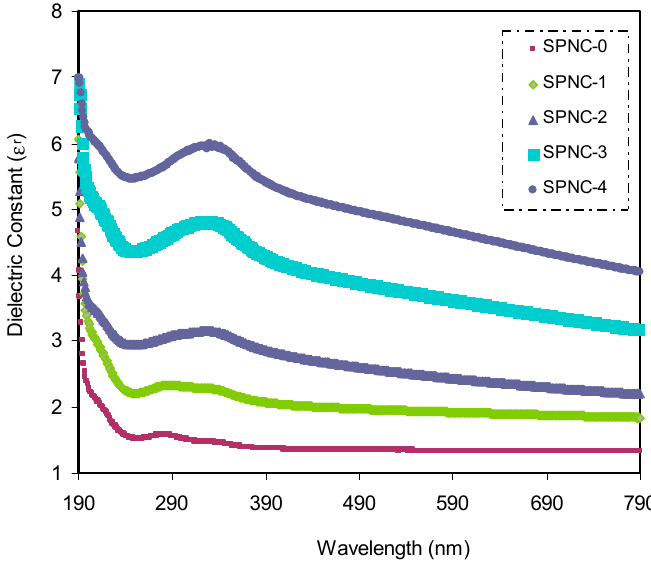
Figure 7. Dielectric constant spectra as a function of wavelength for pure and CeO 2 -doped PVA samples.